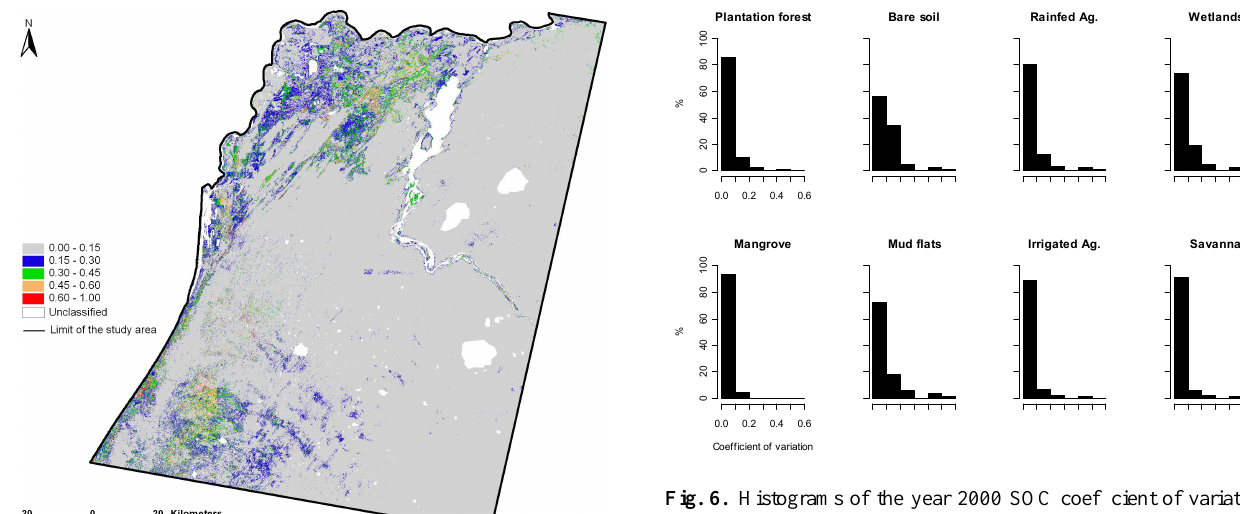
Plantation forest